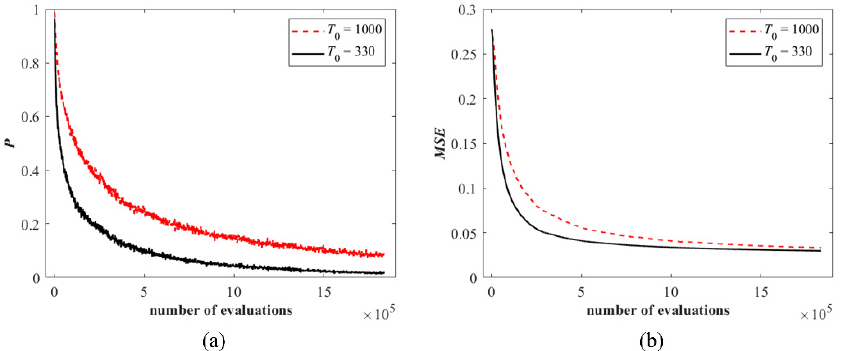
Figure 3. The SABS using different T 0 . ( a ) The probability versus the number of evaluations. ( b ) The MSE versus the number of evaluations.